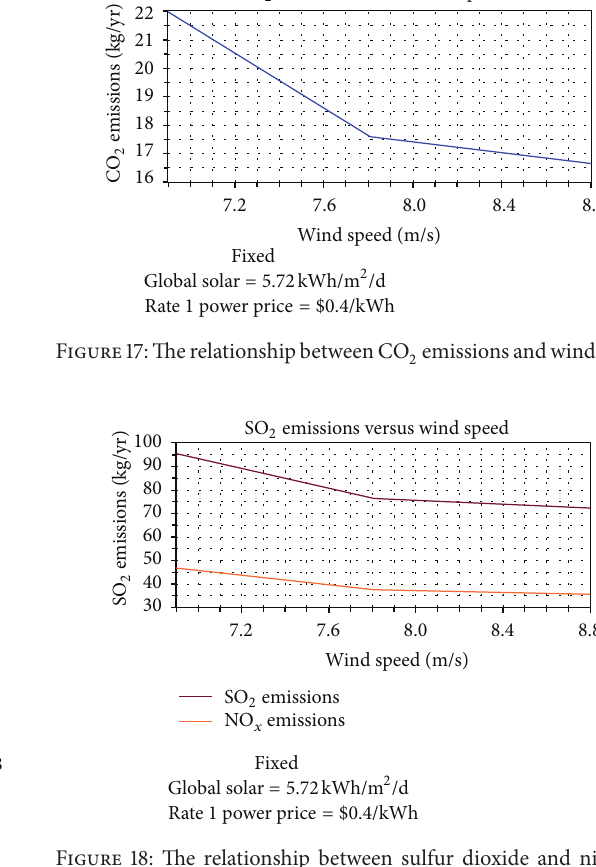
Figure 18: The relationship between sulfur dioxide and nitrogen oxide emissions and wind